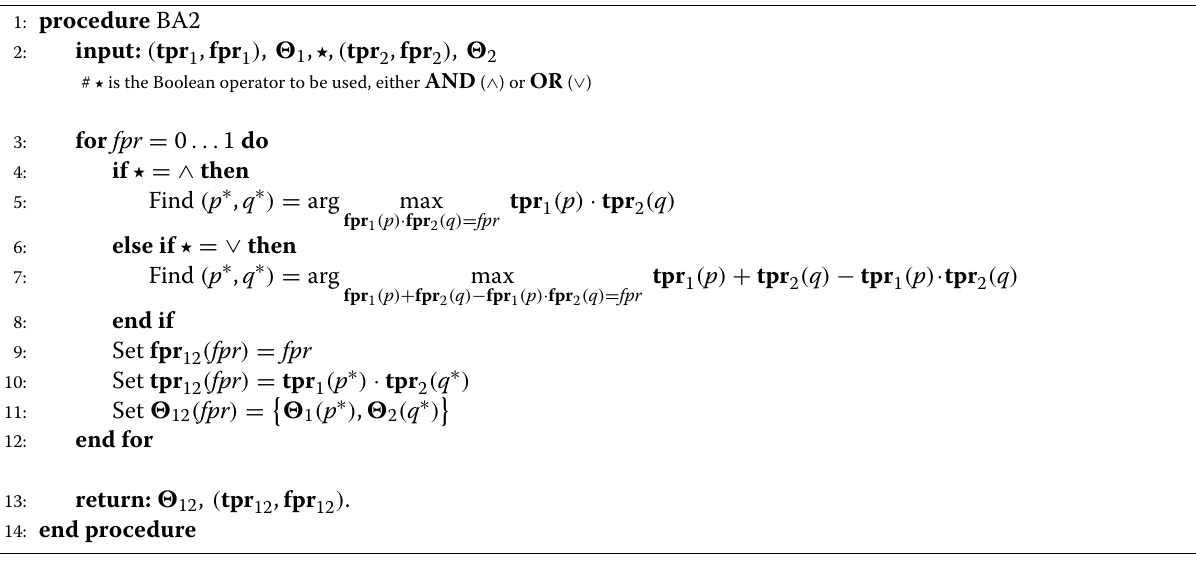
Algorithm 4 Combining ROC curves of two detectors using the Boolean algebra of ROC curves by